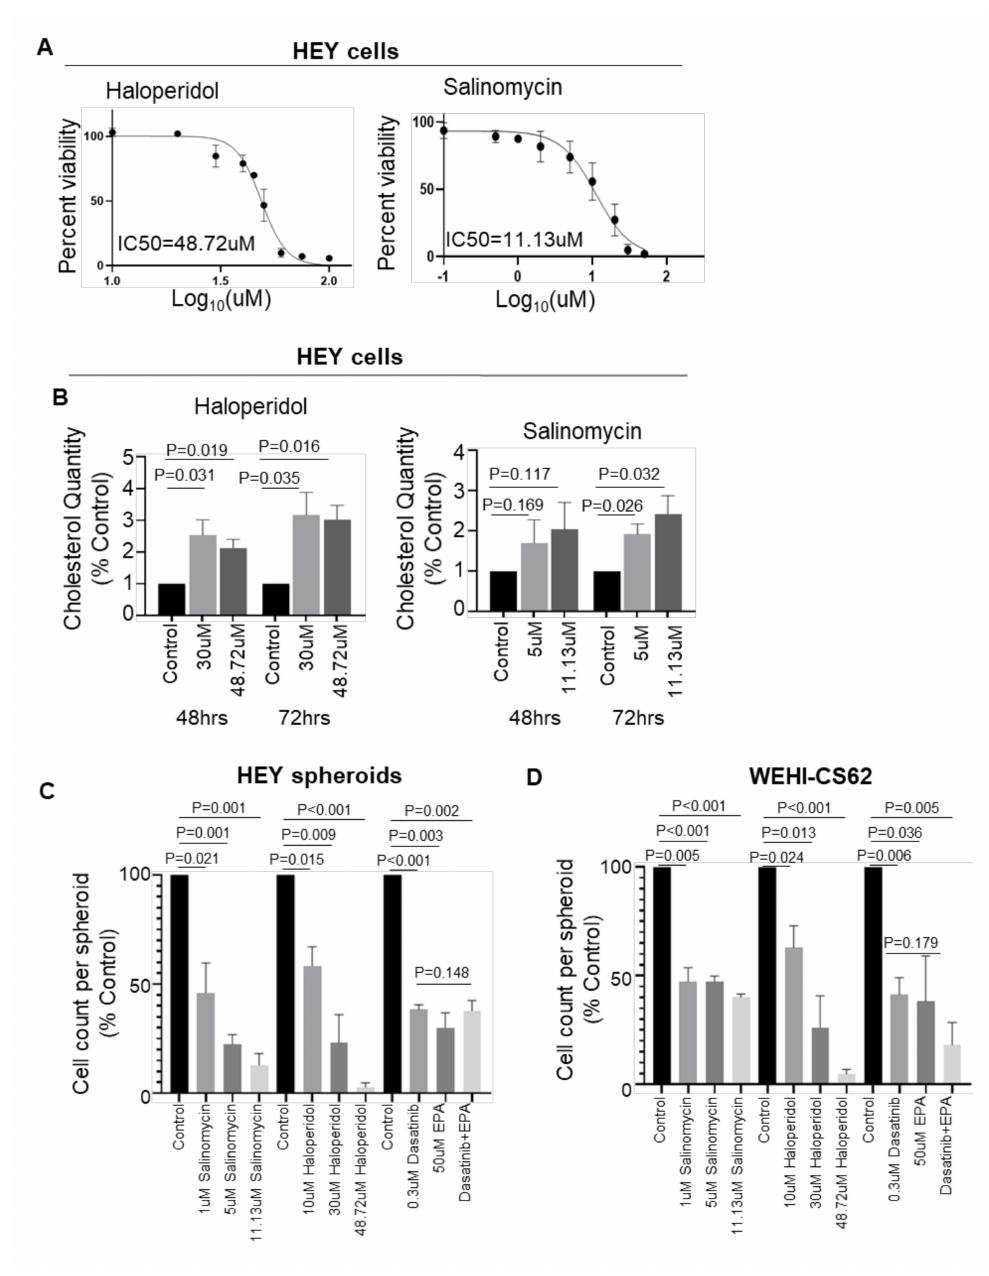
Figure 6. The effect of agents reported to induce cholesterol accumulation on EOC spheroid formation and cell growth. ( A ) Dose–response curves generated by resazurin-based assays showing the half maximal inhibitory concentrations (IC50) of haloperidol and salinomycin upon malignant serous EOC HEY cells after 72 h treatment. Cells were cultured in monolayer conditions. Percent viability is the viability of the drug-treated cells expressed as a percentage of the viability of DMSO-treated cells. ( B ) Cholesterol quantification after 48–72 h showing the effect of salinomycin and haloperidol in HEY cells. Cells were cultured in monolayer conditions. ( C ) Column graphs represent changes in the cell number per spheroid formed by HEY cells after 72 h treatment with vehicle or one of the indicated drugs. ( D ) Column graphs represent changes in the cell number per spheroid formed by the WEHI-CS62 cells after treatment with vehicle or one of the indicated drugs. n = 3 for all experiments. p -Values for ( B – D ) were derived from one-sample t -tests with the exception of cell count comparisons between the dasatinib and EPA combination with single agents alone for which one-way ANOVA with Dunnett’s multiple comparison tests were performed. Results represent the mean ±